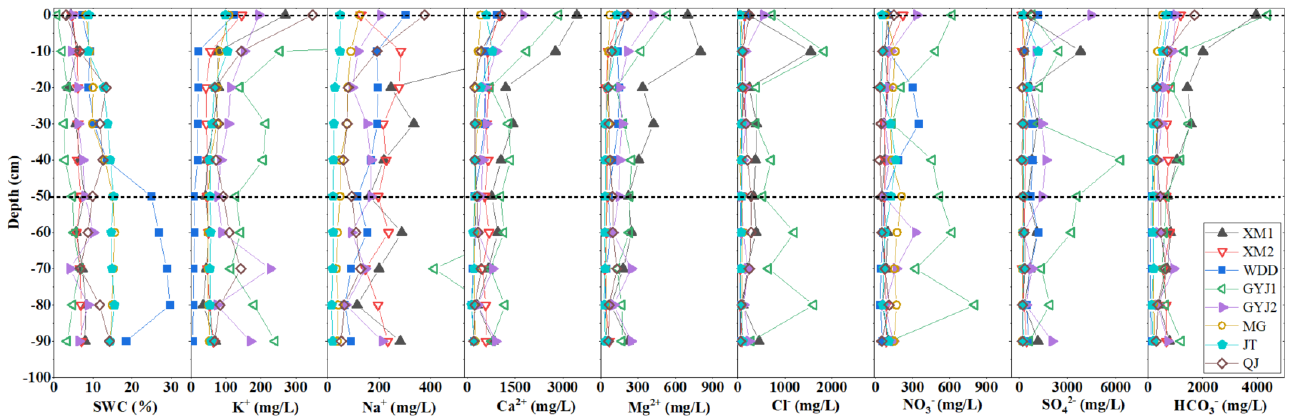
Figure 4. The soil water content and major ions distribution of soil − soluble salt.